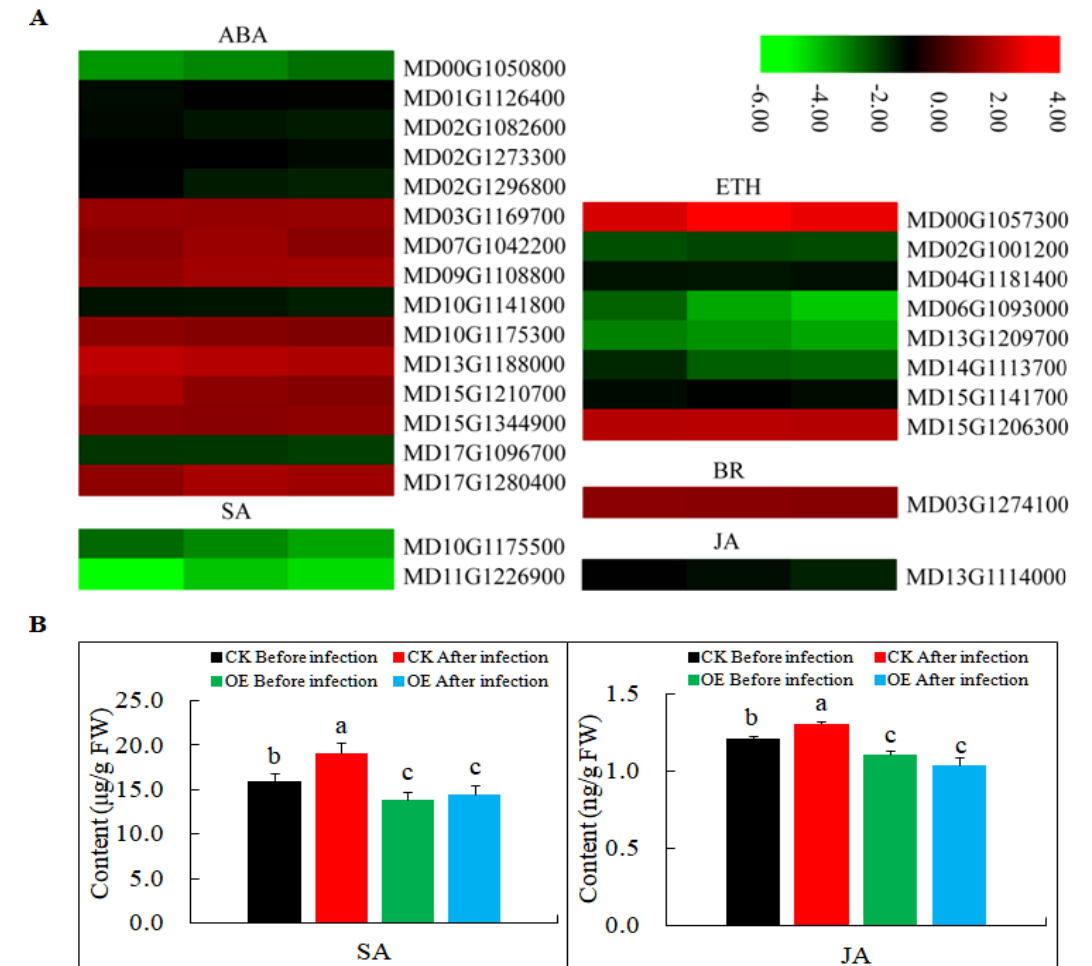
Figure 7. Expression levels of DEGs involved in phytohormone signaling pathways. ( A ) Heatmaps of DEGs involved in phytohormone signaling pathways, including ABA, SA, ETH, BR, and JA signaling pathways in MdMLP423 ‐ overexpressing calli. The log2|Foldchange| was colored using TBtools (red indicates the DEG was up ‐ regulated in the MdMLP423 ‐ overexpressing calli compared with the CK calli, green indicates it was down ‐ regulated). Each row represents three independent comparisons (T_1/CK_1, T_2/CK_2, and T_3/CK_3) from left to right. ( B ) The content of SA and JA before and after pathogen inoculation. The different lowercase letters indicate significant difference at p < 0.05.